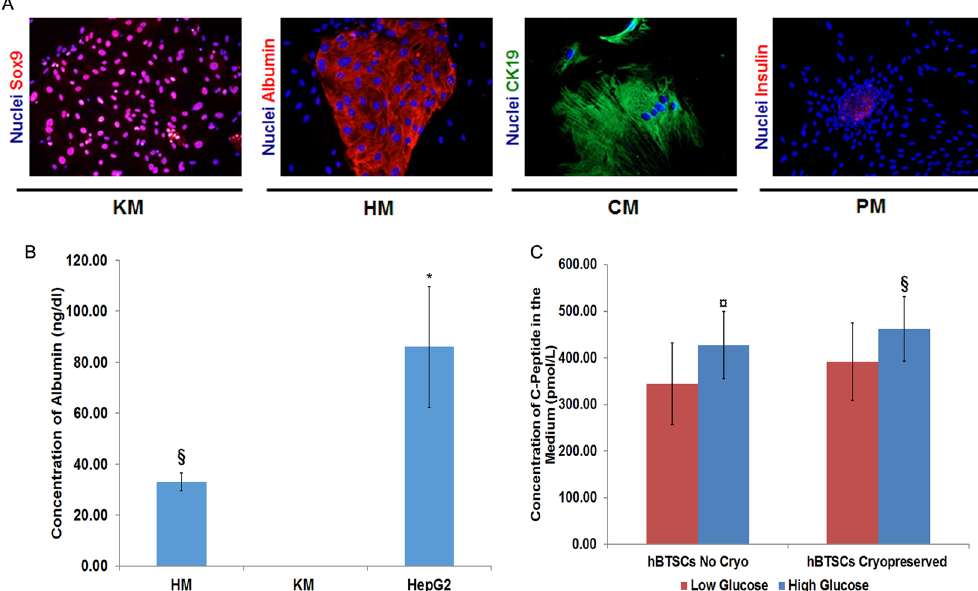
Figure 5. Morphological, phenotypic and functional changes induced by hormonally defined culture media compared to Kubota’s Medium/KM (basal condition) to demonstrate the effective differentiation of cryopreserved hBTSCs. ( A ) Cryopreserved hBTSCs were thawed and then cultured in media specifically tailored to induce differentiation in hepatocytes (HM), cholangiocyetes (CM) or pancreatic cells (PM). After 15 days in HM, cuboidal-shaped cells expressing albumin (hepatocyte markers) were evident (N = 5). After 15 days in CM, clusters of cells expressing CK19 appeared (N = 5). After 14 days, the monolayers in PM transition to dense balls of aggregated cells budding from the edges of the colonies and containing cells expressing insulin (Figure 10) (N = 5). Figures are representative of cultures of cells cryopreserved in Sol1 (N = 5). ( B ) The differentiation of cryopreserved hBTSCs thawed and cultured in hepatocytic medium (HM) was demonstrated by the albumin secretion with respect to control cells cultured in self-renewal conditions in Kubota’s Medium (KM) (data are expressed as mean ± SD of 6 experiments; § p < 0.01 HM vs KM), that resulted lower with respect to HepG2 ( * p < 0,05 HepG2 vs KM), but similar to freshly isolated cells (not shown). ( C ) In pancreatic medium (PM), both cryopreserved and freshly isolated hBTSCs acquired insulin (C-Peptide) secretion property that was regulated by glucose concentration (data are expressed as mean ± SD of 7 experiments; § p < 0.01 low vs high glucose concentration, ¤ p < 0.001 low vs high glucose